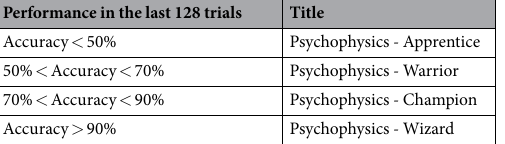
Table 2. Performance based achievement levels: These achievement levels were displayed on the screen during